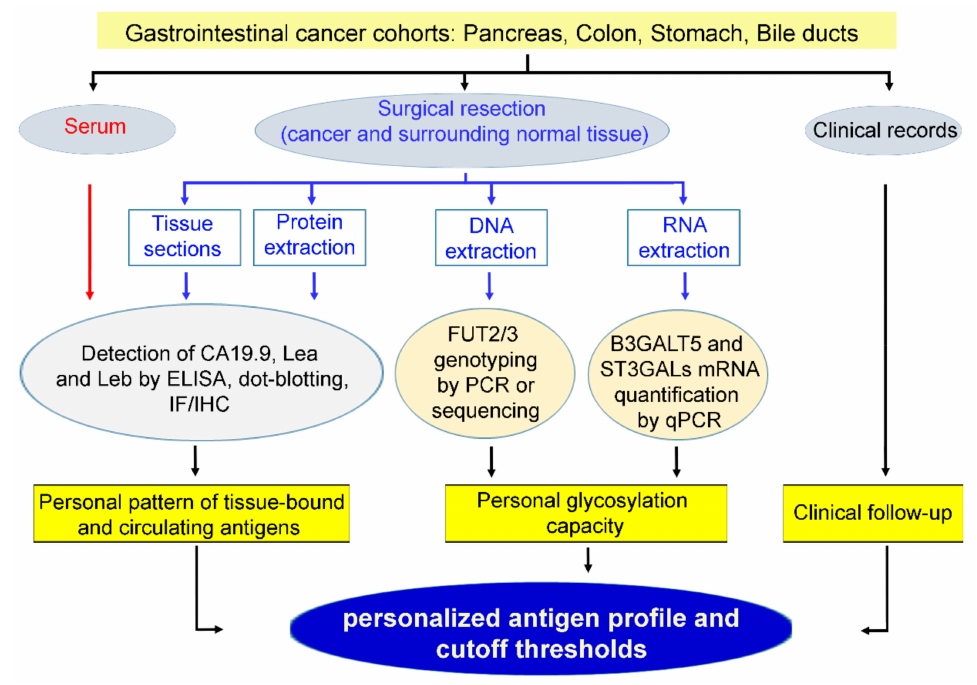
Figure 2. Flowchart of the approach proposed for using Lewis type 1 chain antigens as personalized tumor markers. IF: immunofluorescence; IHC: immunohistochemistry. Our working hypothesis is that the epitope of the CA19.9 antigen is not overproduced in cancer cells nor distinct from the related carbohydrate antigens Lea and Leb in a cancer-associated manner. Consequently, they should be considered together, taking into account their frequent expression, which is sometimes abundant in normal tissues. At the molecular level, the concurrent amounts of two transcripts, FUT3 and B3GALT5, appear highly predictive of the expression levels of all three antigens, while the levels of FUT2 / 1 and ST3GALs a ff ect the relative quantity of each individual antigen. At present, complete and homogeneous data are not available in human samples, and those found in cell lines are not predictive. Transcript and antigen expression in normal colon mucosa and colon cancer is well documented (Table 1), while parallel data on the antigen expression in patient serum are not